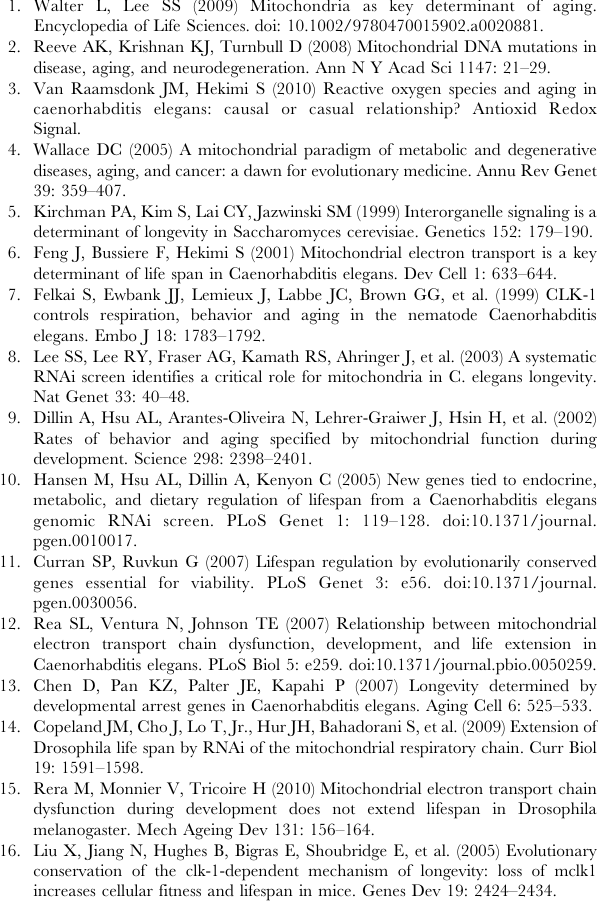
Table S3 Quantitative data and statistical analyses of